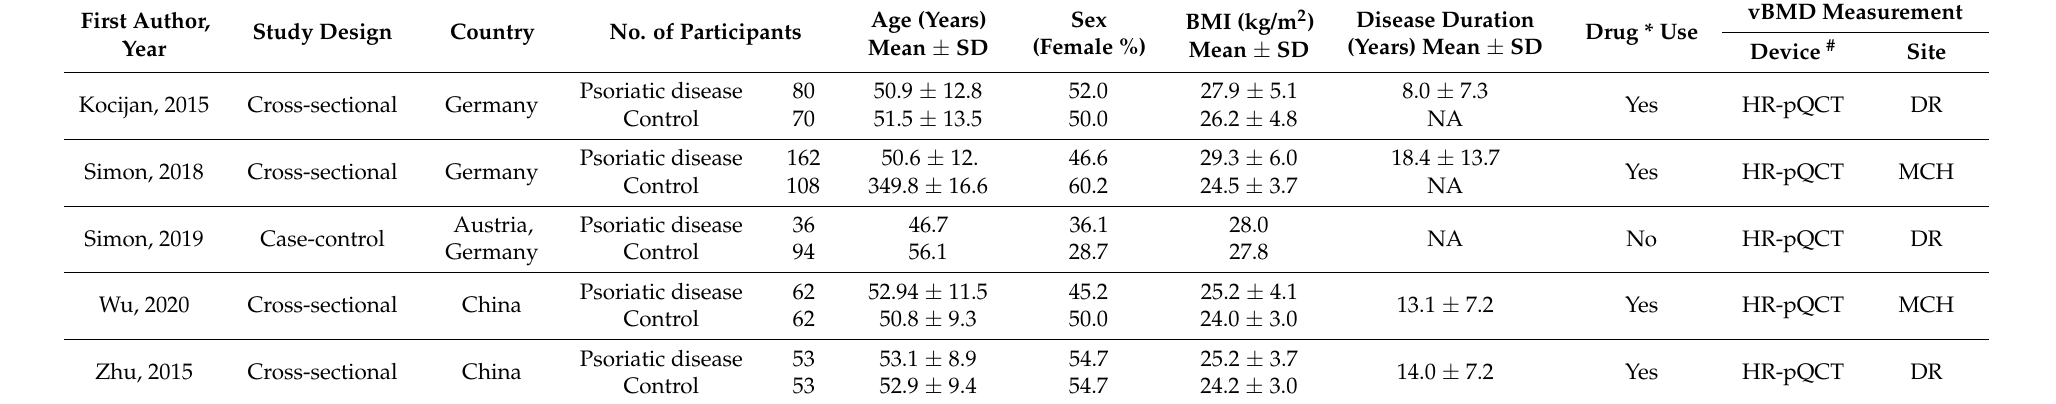
Table 1. Characteristics of included